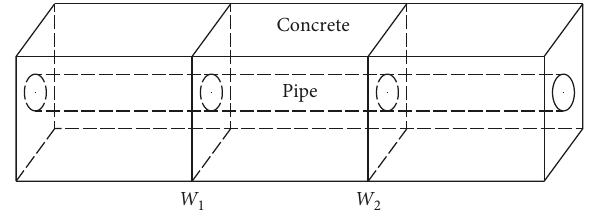
Figure 2: Geometrical model of the 3D domain with segments used for fluid temperature calculations.